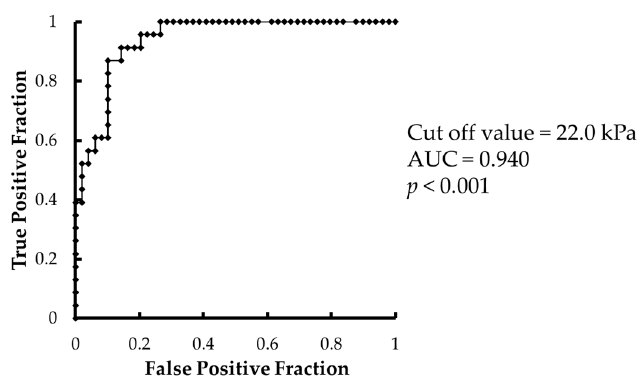
Figure 3. Receiver operating characteristic curve of tongue pressure versus crushability of the HJ with the tongue.